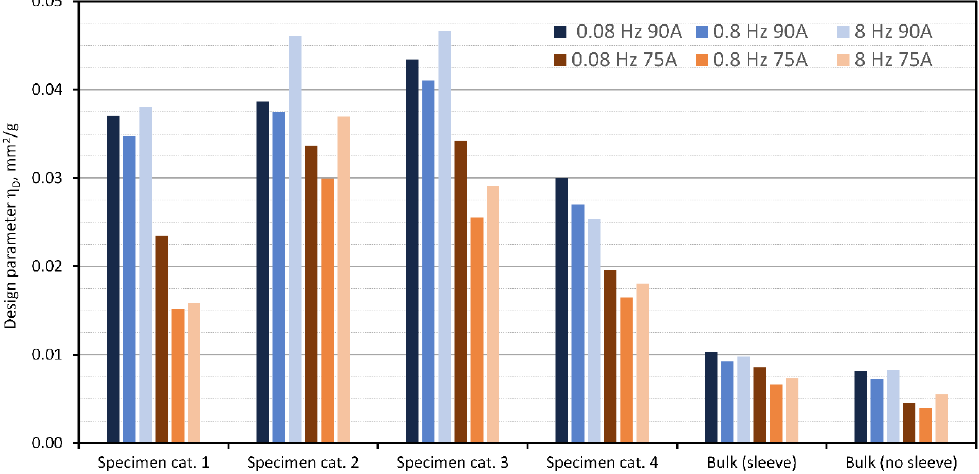
Figure 12. Calculated design parameter 𝜂 D for each testing condition and both materials.